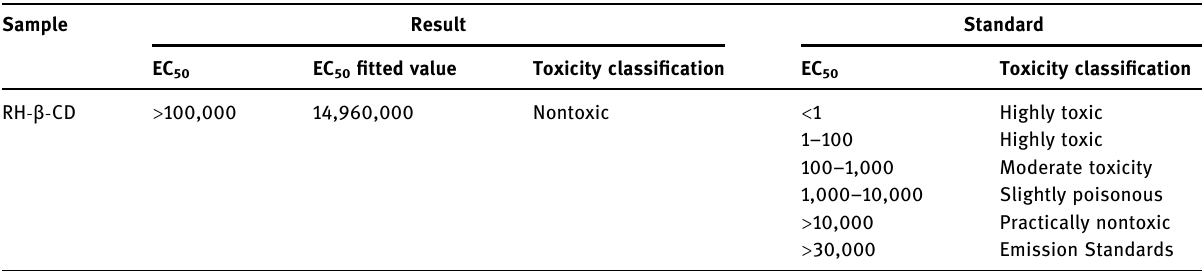
Table 1: Biological toxicity test results of RH - β - CD Sample